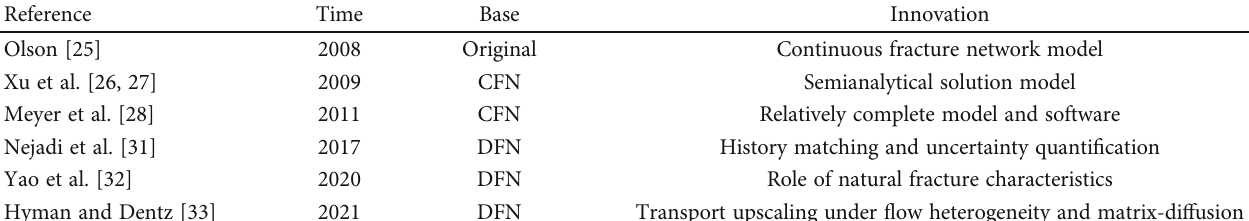
Table 1: Comparison of di ff erent continuous fracture network models.